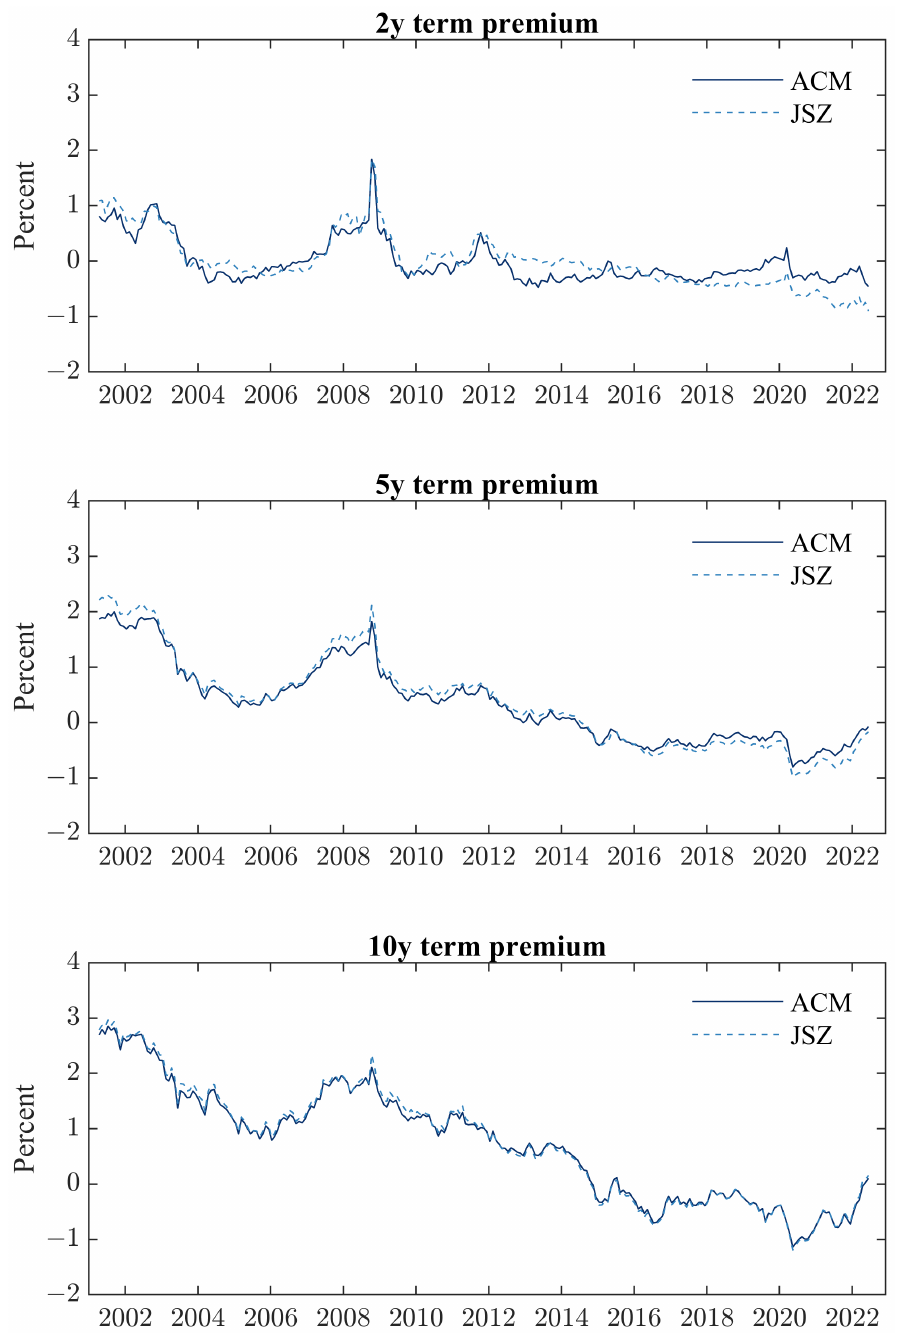
Figure 2. Term premia